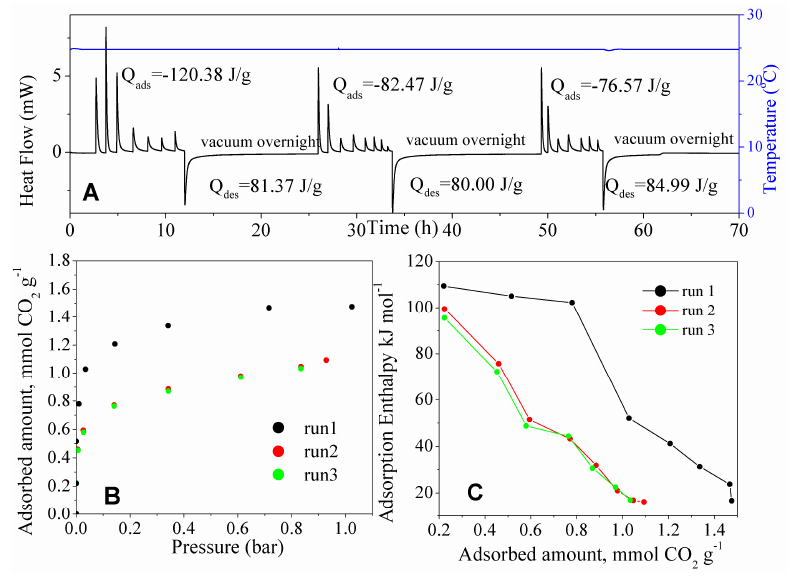
Figure 10. ( A ) Thermogram (at 25 °C) for CO 2 adsorption on the three rounds; ( B ) corresponding CO 2 adsorption isotherms; and, ( C ) Differential enthalpies of CO 2 adsorption (at 25 °C) for the three rounds of adsorption on the same MSG20I30 sample.